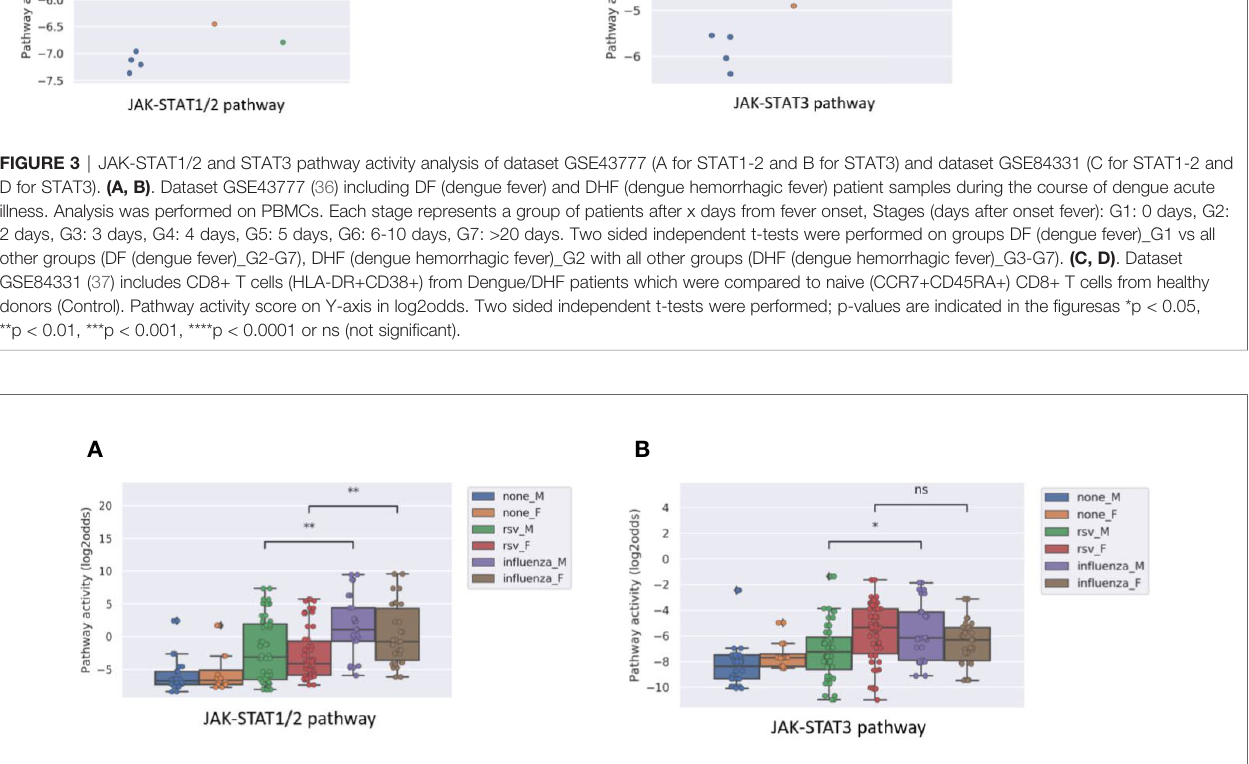
FIGURE 4 | JAK-STAT1/2 (A) and STAT3 (B) pathway activity analysis of dataset GSE34205 (38), including children (M=male; F=female) of median age of 2.4 months (range 1.5-8.6) hospitalized with acute RSV and in fl uenza virus infection. Blood samples were collected within 42 – 72 h of hospitalization and PBMCs were isolated for analysis and compared with healthy controls. Pathway activity score on Y-axis in log2odds. Two sided Mann – Whitney – Wilcoxon statistical tests were performed; p-values are indicated in the fi gures as *p < 0.05, **p < 0.01, or ns (not signi fi